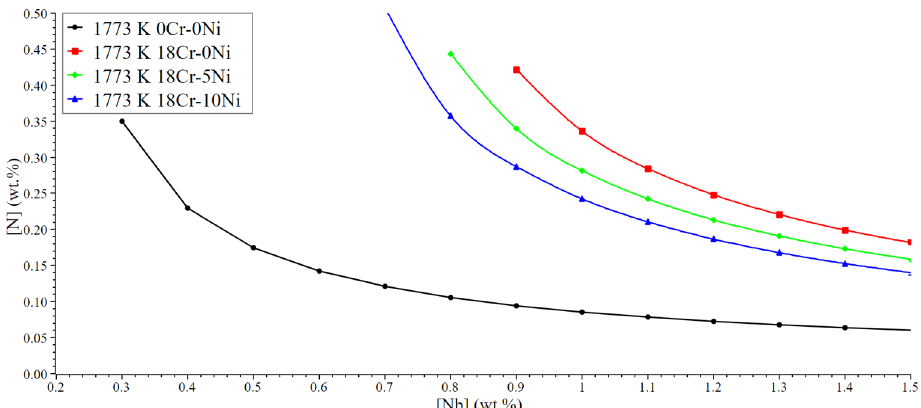
Figure 2. Temperature dependence of the equilibrium solubility product of niobium and nitrogen in liquid steel melt.